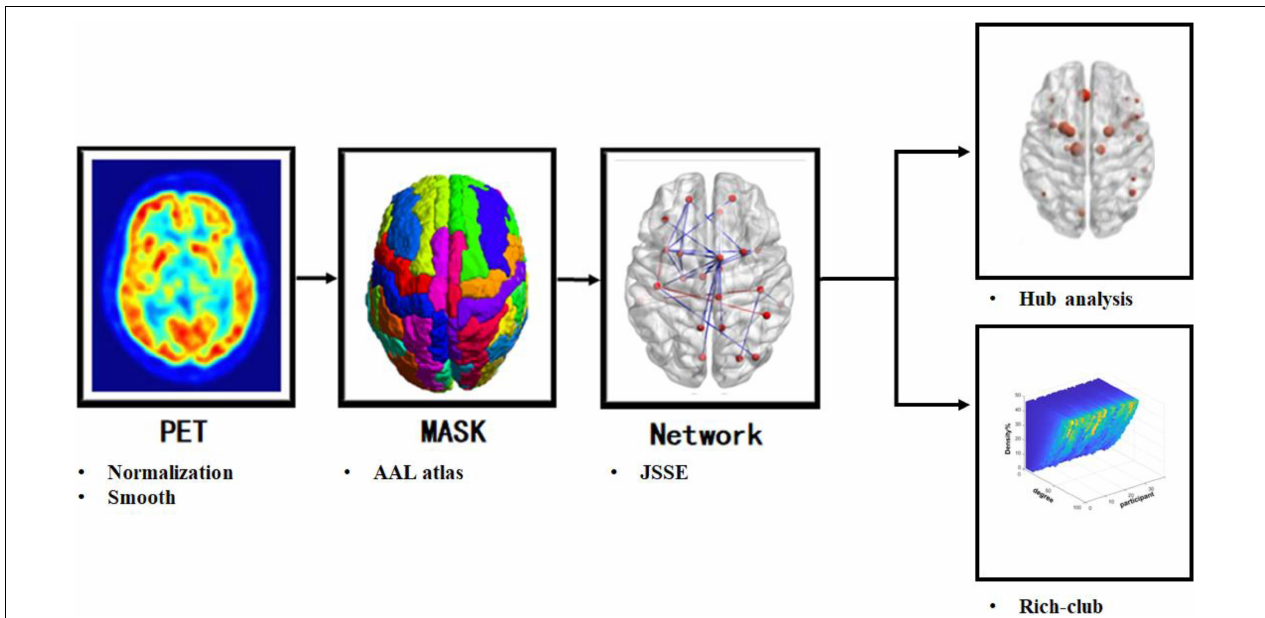
FIGURE 1 | The flow diagram of positron emission tomography (PET) images preprocessing, individual metabolic network construction and analyzes. The flow diagram shows the preprocessing of PET images, construction of the individual metabolic network based on JSD, hub analysis and rich-club analysis.